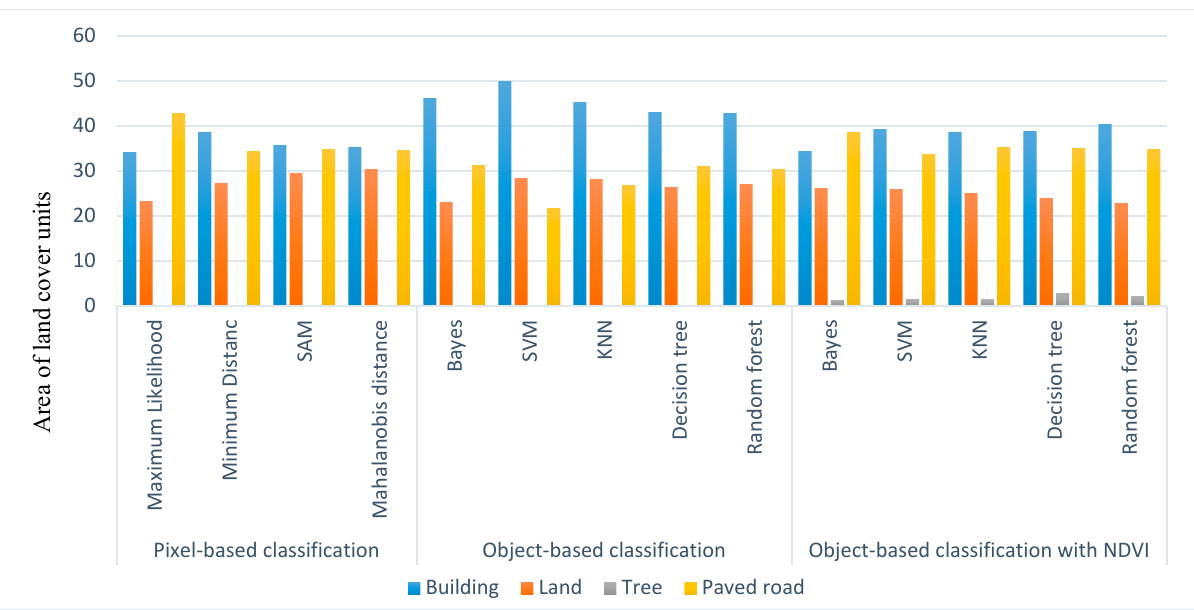
Figure 8. Percentage area of different land cover units (buildings, barren land, trees, roads) identified when using pixel-based, object-based and object-based with normalized difference vegetation index (NDVI) methods to classify Sentinel-2 images.